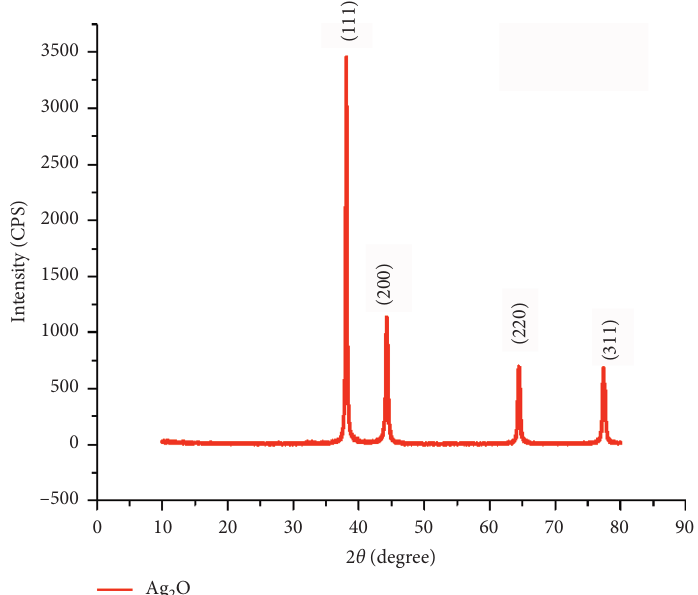
Figure 6: XRD pattern of synthesized Ag